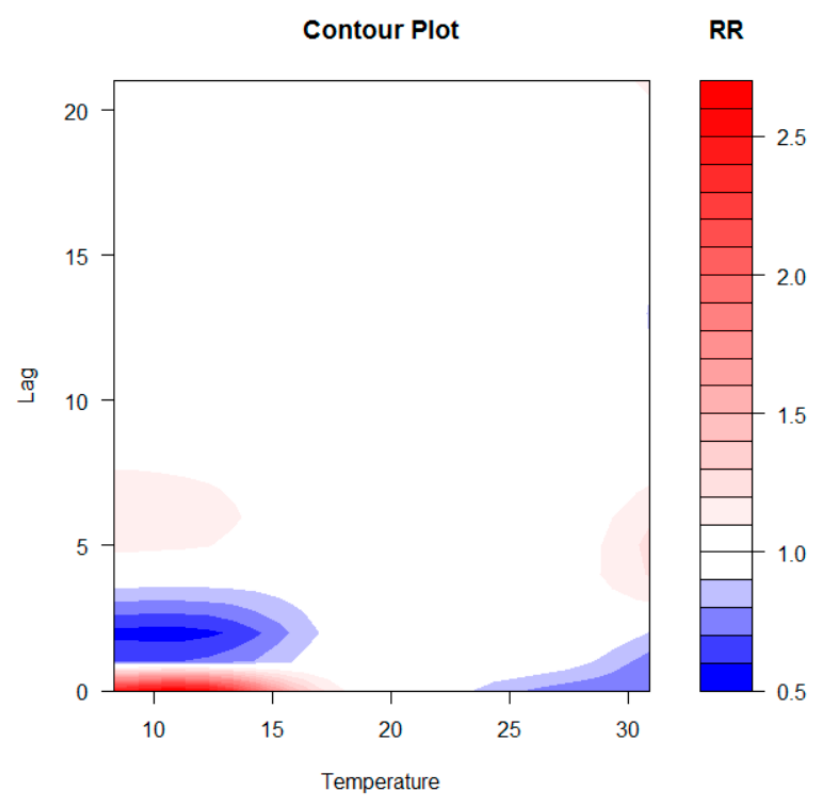
Figure 8. Contour plot of RR of CVD hospital admissions along temperature and lags with references of 20 ◦